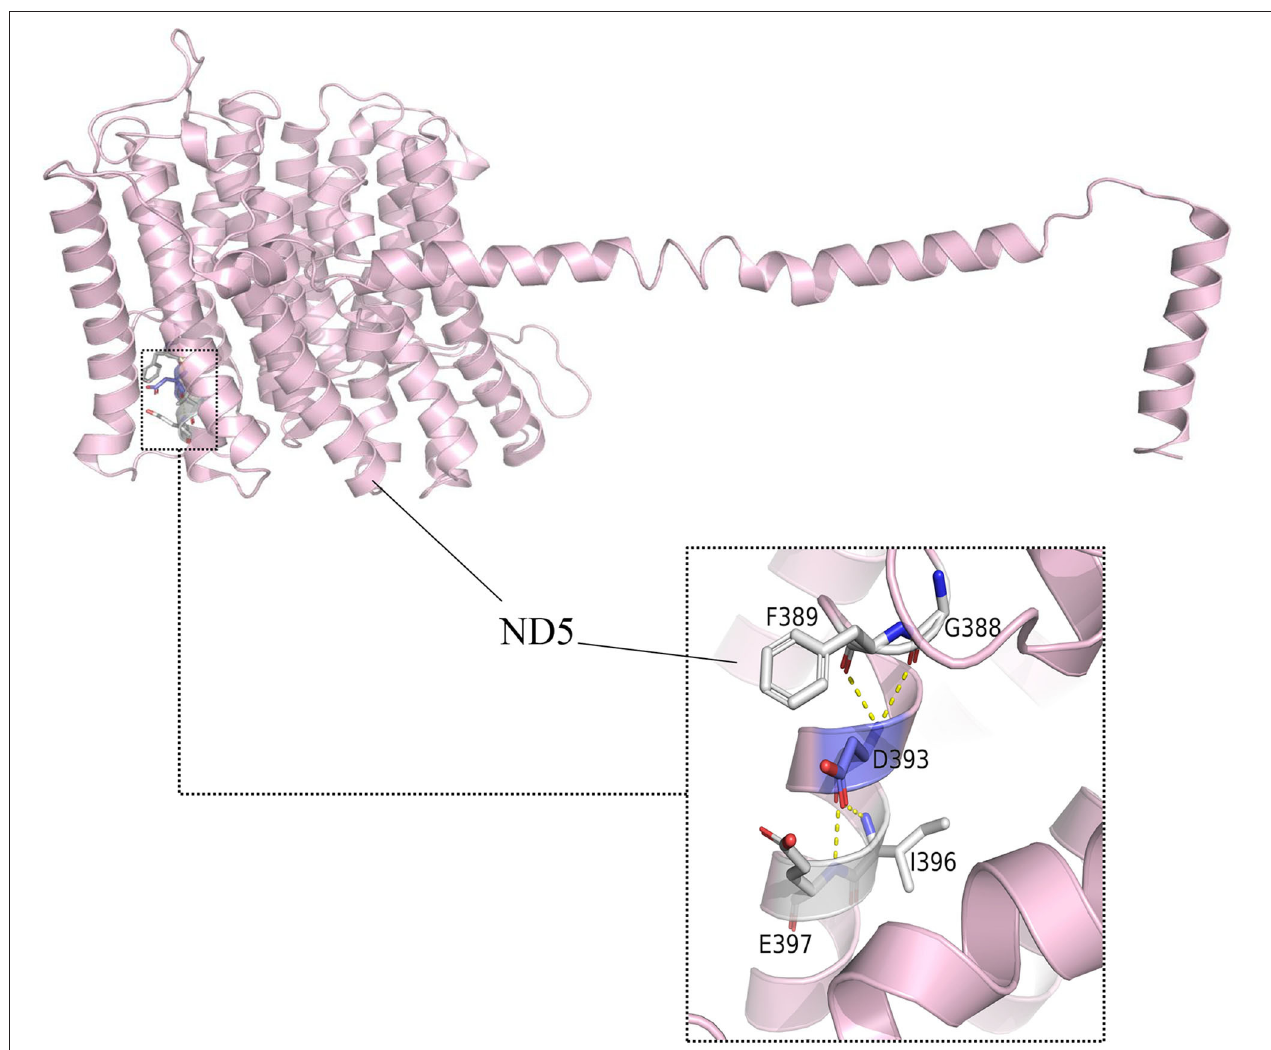
FIGURE 5 | Altered complex I assembly. Structural interactions of ND5-D393 (5XTD in the protein bank). The hydroxyl group of D393 forms specific electrostatic interactions with G388, F389, I396, and E397 in MT-ND5.